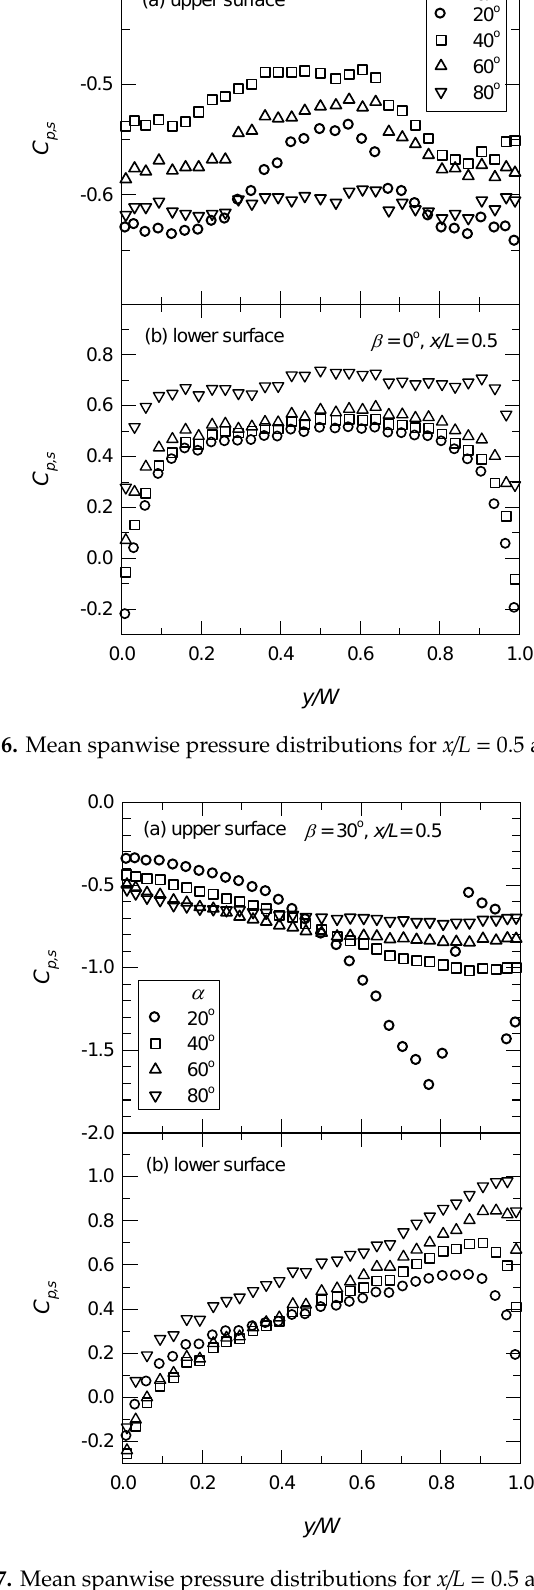
Figure 7. Mean spanwise pressure distributions for x/L = 0.5 and β = 30°.